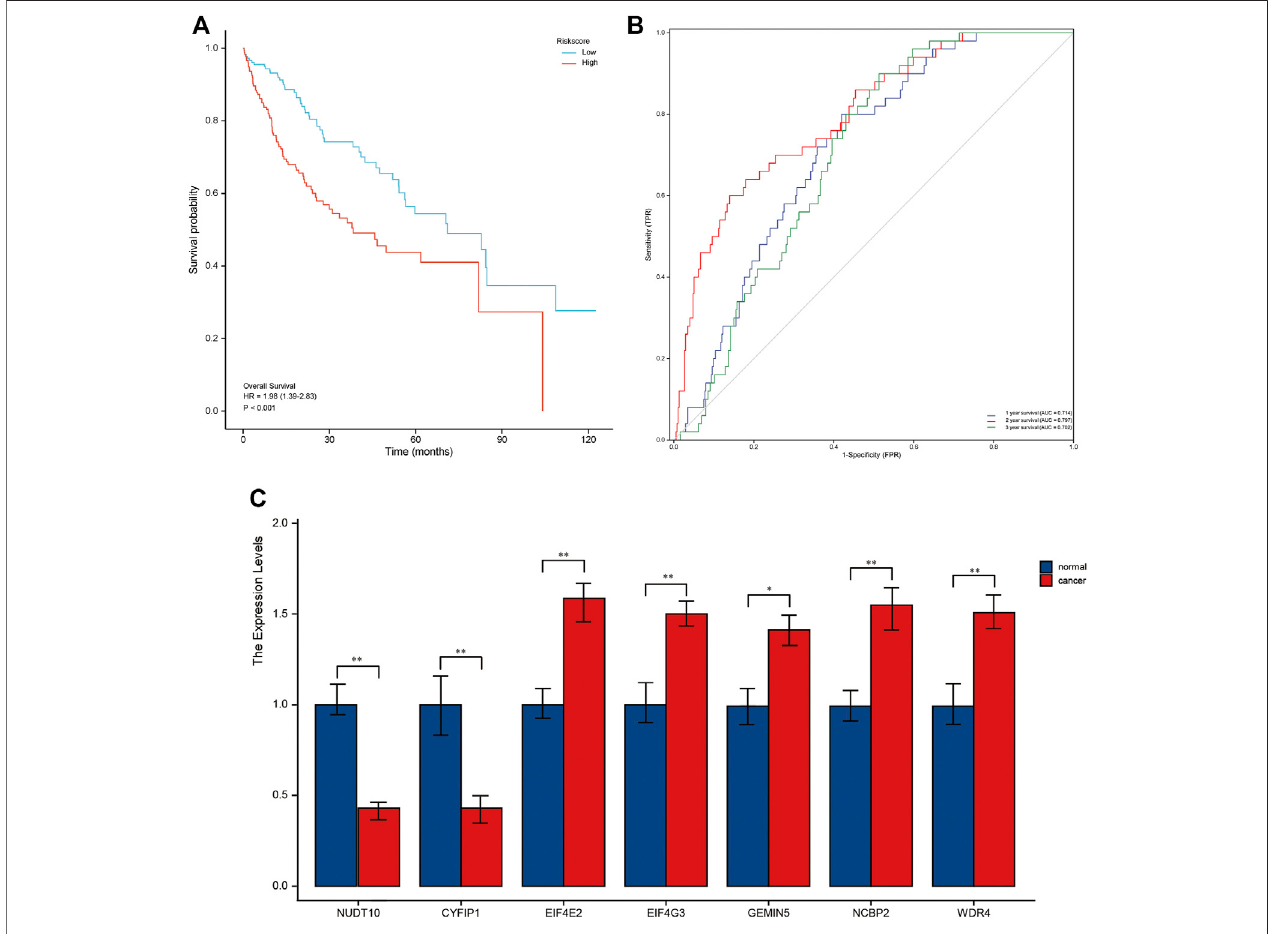
FIGURE4| Avalidationcohortwasusedtovalidatethesevenm7G-relatedgenes. (A) .Kaplan – Meiercurvesshowingoverallsurvivalofpatientsinthehigh-riskand low-risk groups. (B) . The area under the curves of time-dependent ROC curves indicates the risk score ’ s prognostic performance. (C) . Results of quantitative real-time PCR